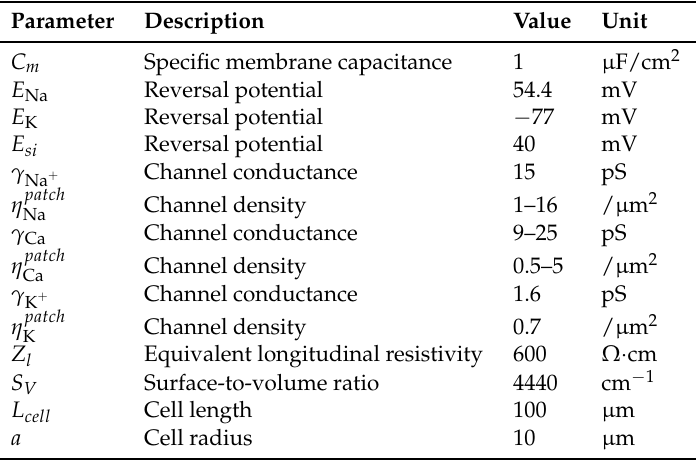
Table 2. Parameters used in the simulation framework.